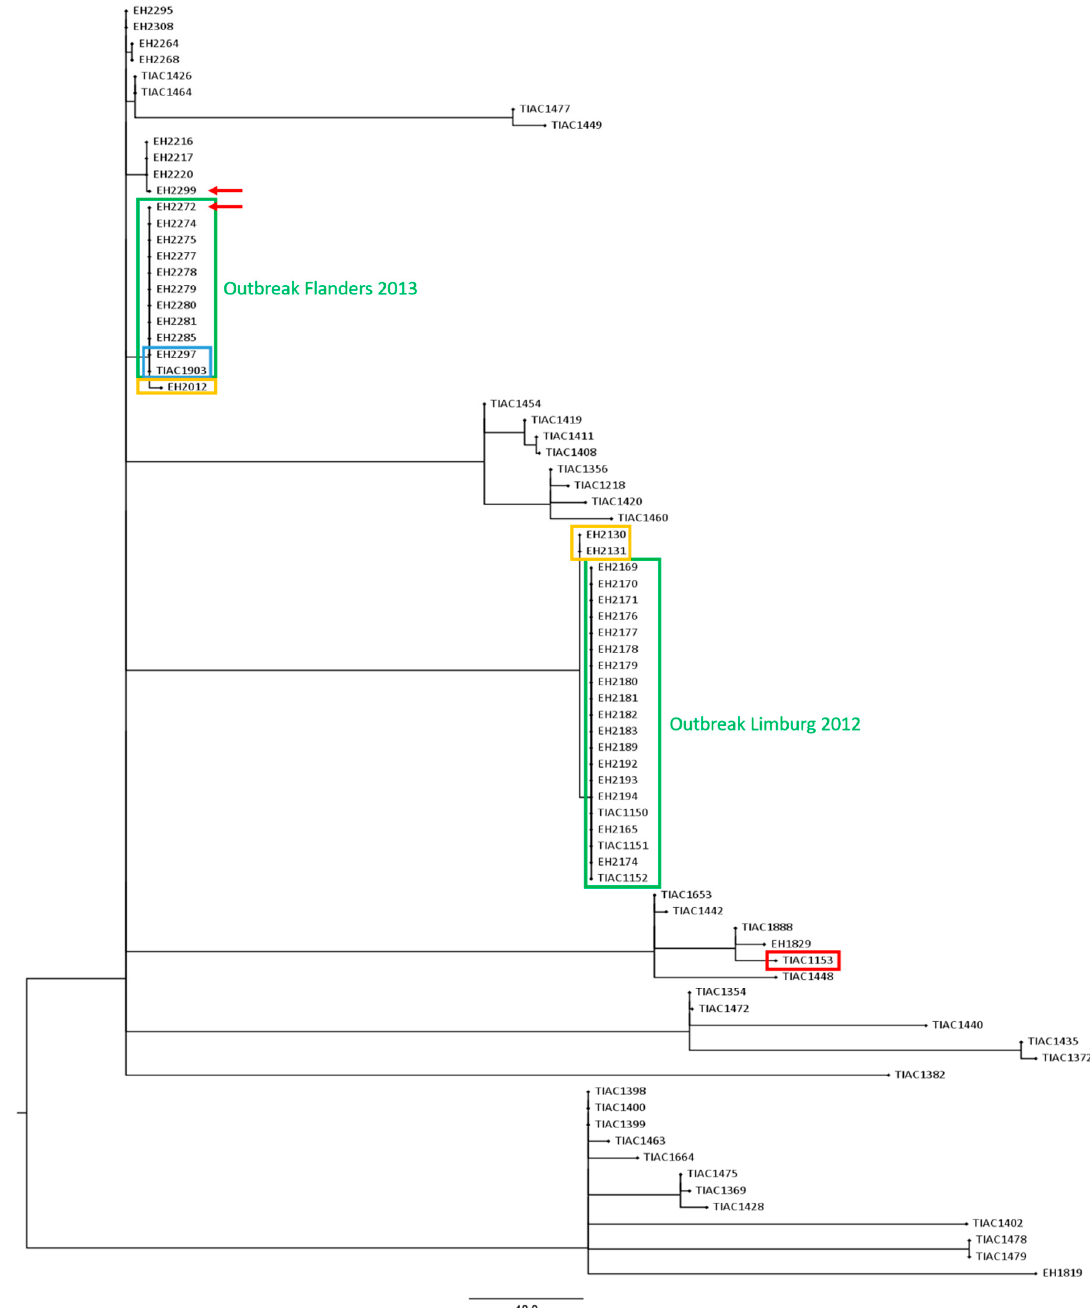
Figure 2. A cgMLST tree of all suspected outbreak isolates (Limburg 2012 and Flanders 2013) and the 41 background isolates. A minimum spanning tree was made based on the cgMLST allele matrices of all isolates using the MSTreeV2 method with GrapeTree. The outbreak clusters of Limburg 2012 and Flanders 2013 are outlined in green boxes. The cow carcass isolate that was discriminated from the Limburg 2012 outbreak cluster is visualized with a red box. Isolates that were identified with WGS to be closely related to the outbreak cluster are outlined in a yellow box. The two isolates of the 2013 outbreak in Flanders (EH2297 and TIAC1903) for which laboratory confirmation of the link was supported by epidemiological information are outlined in a blue box. Moreover, the isolates for which conventional PFGE and IS629 profiling was non-corresponding, are indicated with a red arrow. The scale bar represents the absolute number of cgMLST allele differences between isolates.